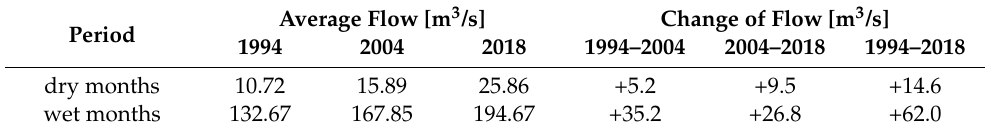
Table 12. Observed average flow during the dry and wet